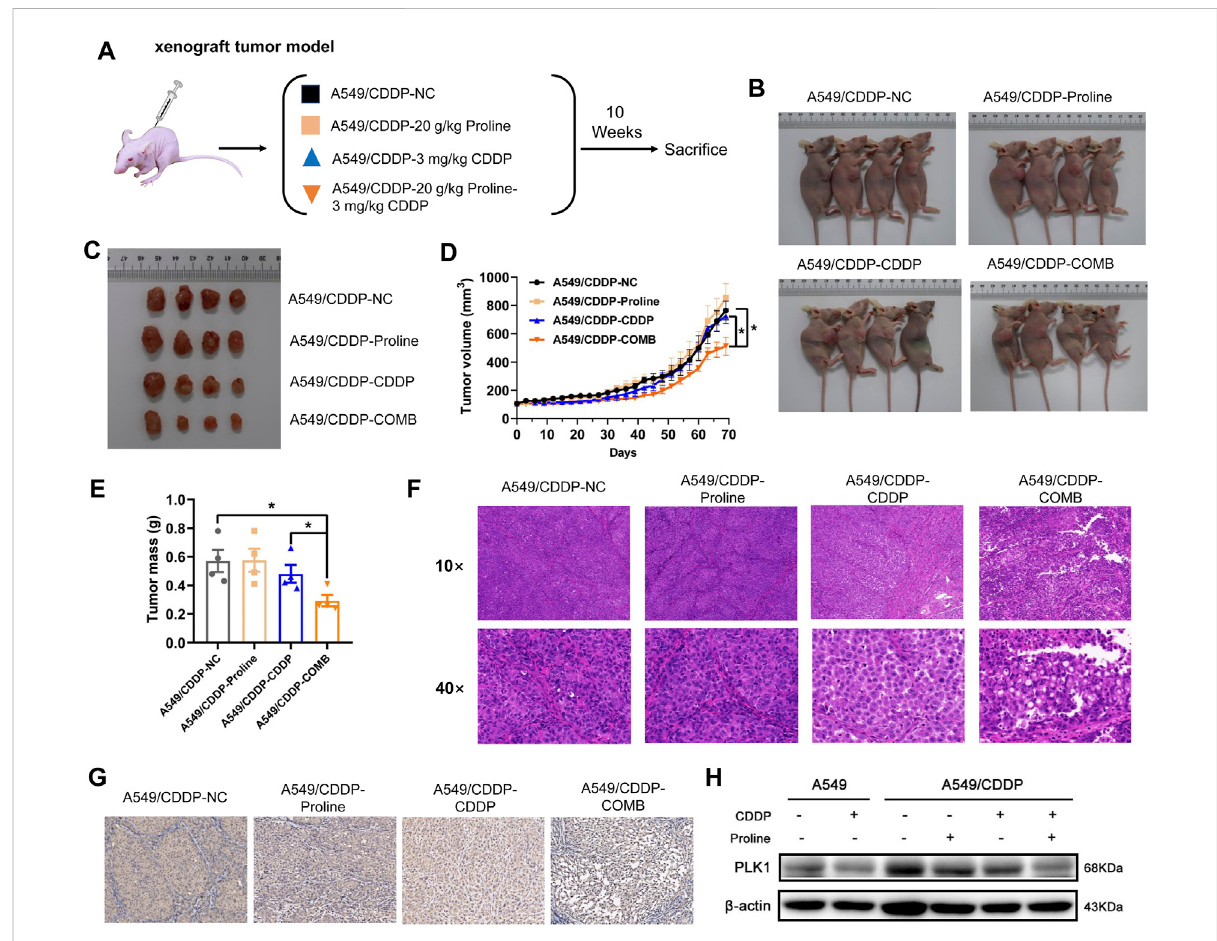
FIGURE 4 Combination of proline and cisplatin results in NSCLC growth inhibition in vivo . (A) The xenograft tumour model investigates the effects of 20 g/kg proline, 3 mg/kg cisplatin and their combined therapy on cisplatin-resistant A549 cells. (B) Representative imaging of mice 10 weeks after injection of A549/CDDP cells upon different treatments. (C) Combined treatment of proline and CDDP effectively inhibited A549/CDDP cell ’ s subcutaneoustumourgrowthinnudemice. (D) Thetumourvolumewasmonitoredevery3 daystogeneratethetumourgrowthcurves. (E) The tumours were extracted and weighed. (F) H&E-stained tumour sections. (G) Sections of tumours were stained with PLK1 antibody by immunohistochemical analysis. (H) Detection of protein expression levels of PLK1 in various groups by western blotting. The data are the means ± SEMs of three independent experiments. * p <